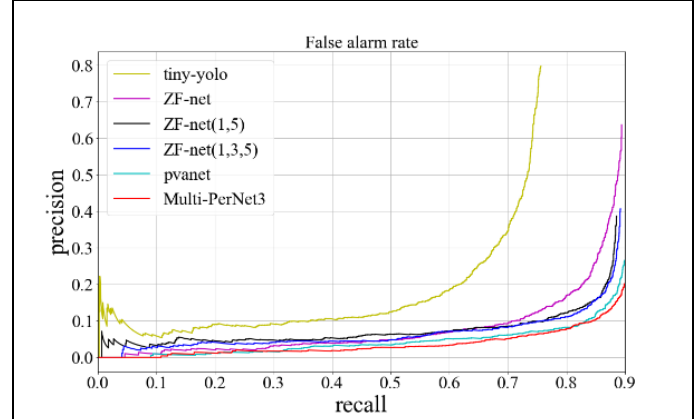
Figure 15. False-alarm rate curve. Table 4. Comparison of model results.